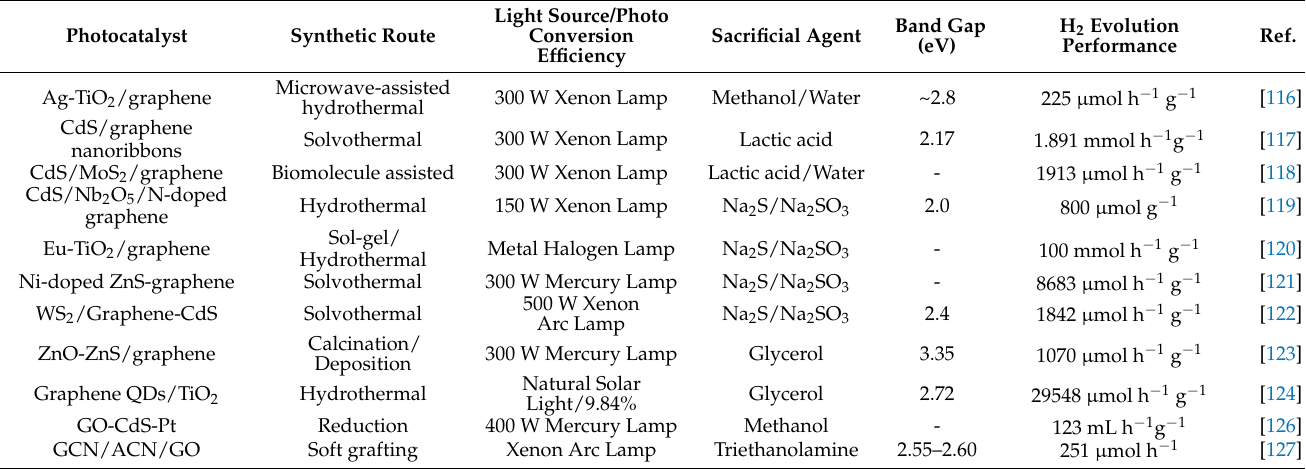
Table 3. Photocatalytic activity of graphene and its derivatives based